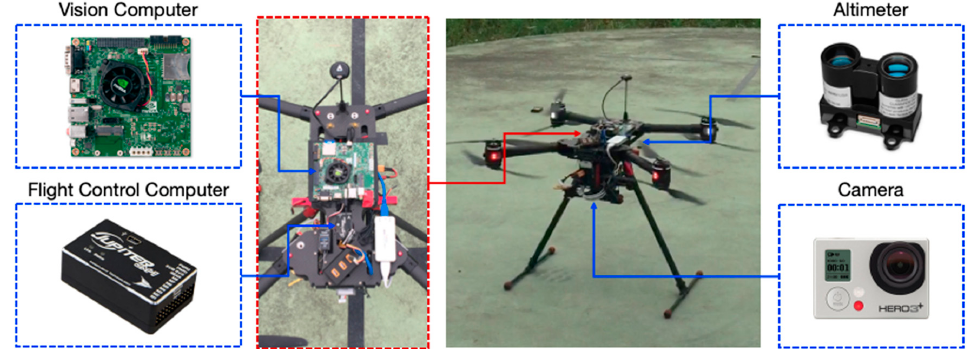
Figure 7. The testbed used in the experiments. In addition to the integrated flight control system, the quadrotor is augmented with a vision processing system and an external camera (30 fps).